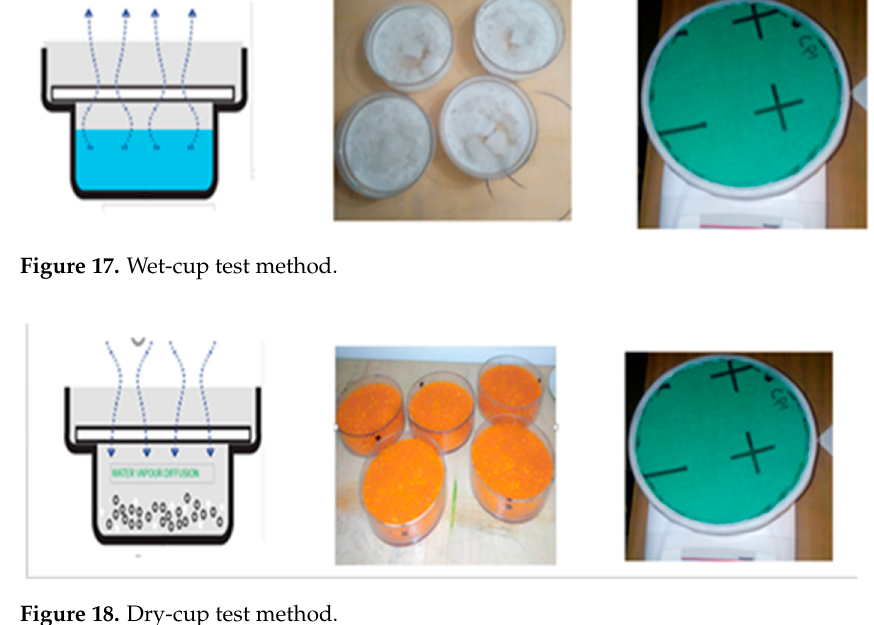
Figure 18. Dry-cup test method.